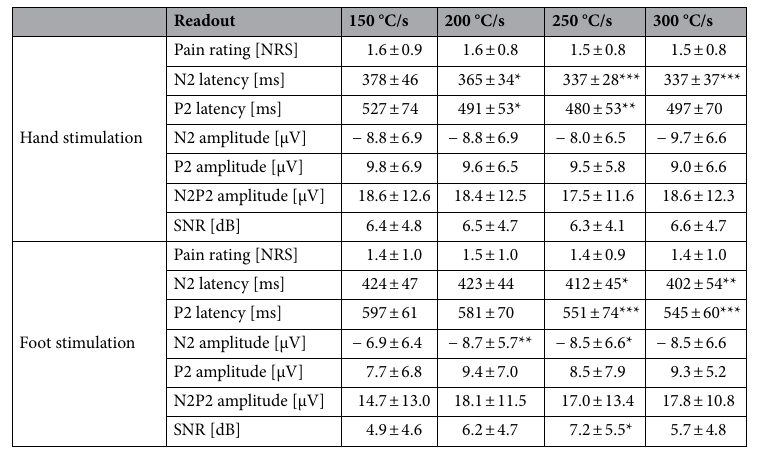
Table 3. Mean and standard deviations of CHEP parameters. Data is presented in mean ± standard deviation. Significance is shown in comparison to 150 °C/s. *p < 0.05, **p < 0.01, ***p < 0.001. NRS: numeric rating scale, SNR: signal-to-noise ratio.